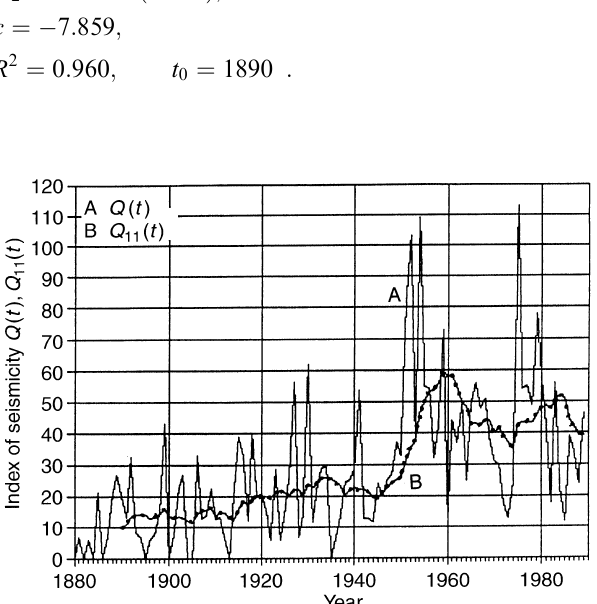
Fig. 9. California seismicity